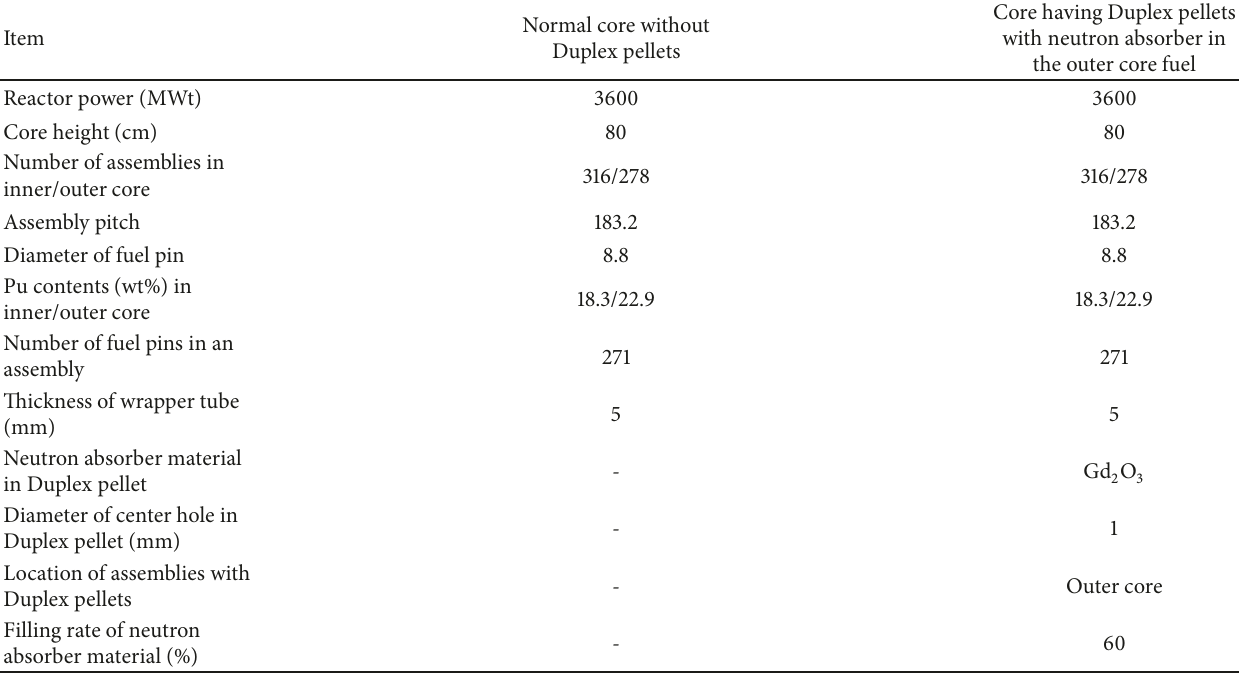
Table 1: Core specifications of normal core and the core having Duplex pellets with neutron absorber.